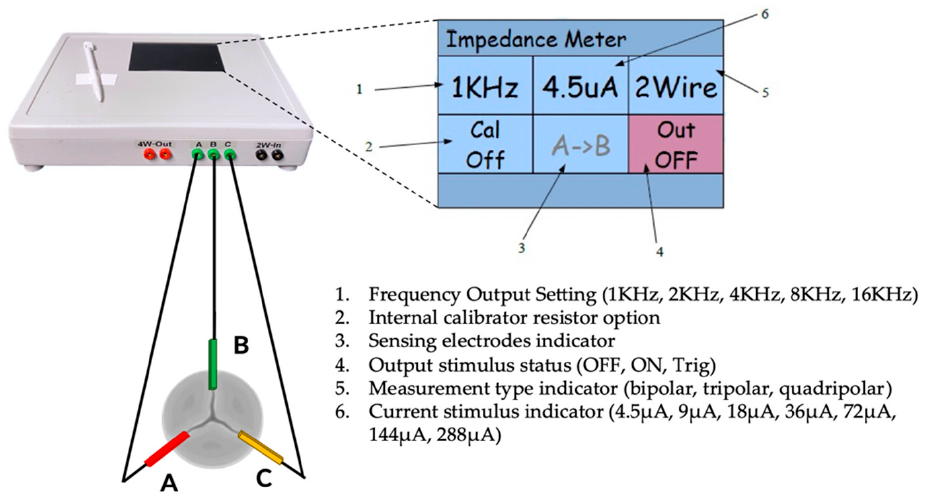
Figure 2. The impedance meter connected to the electrodes (A, B, C) of the sensorized valve and its settings.